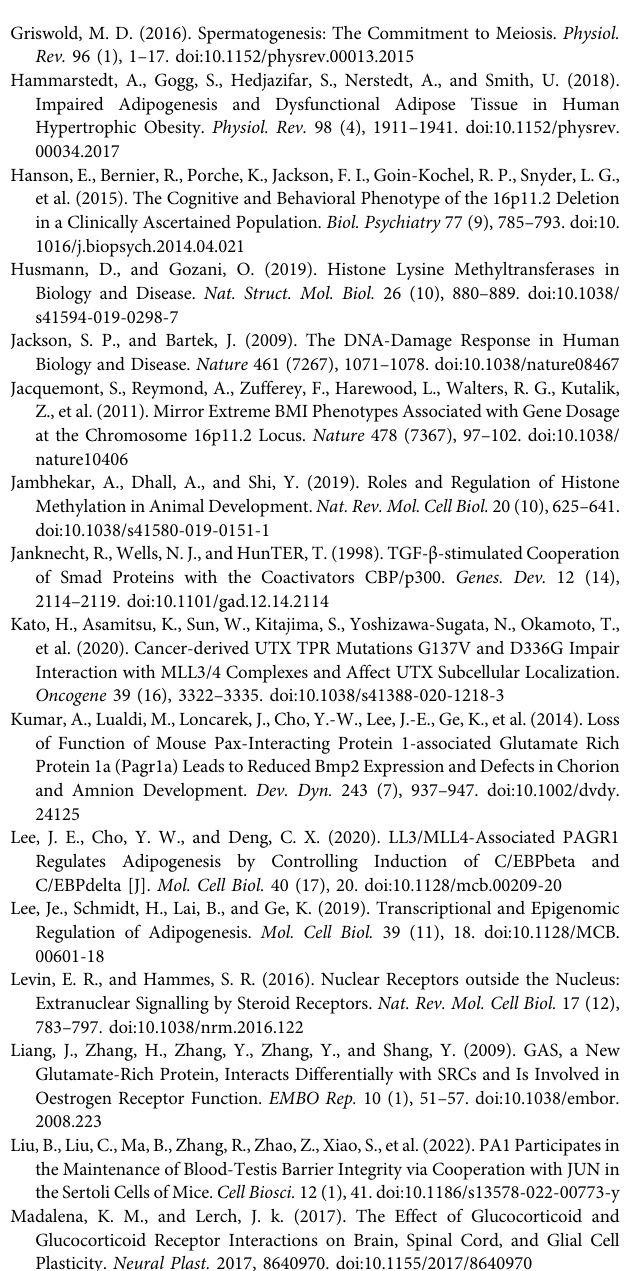
Supplementary Figure S2 | The expression of PA1 in different tumor cell lines according to the GeneCards